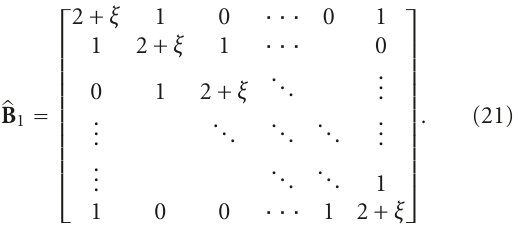
Algorithm 1: Summary of the proposed